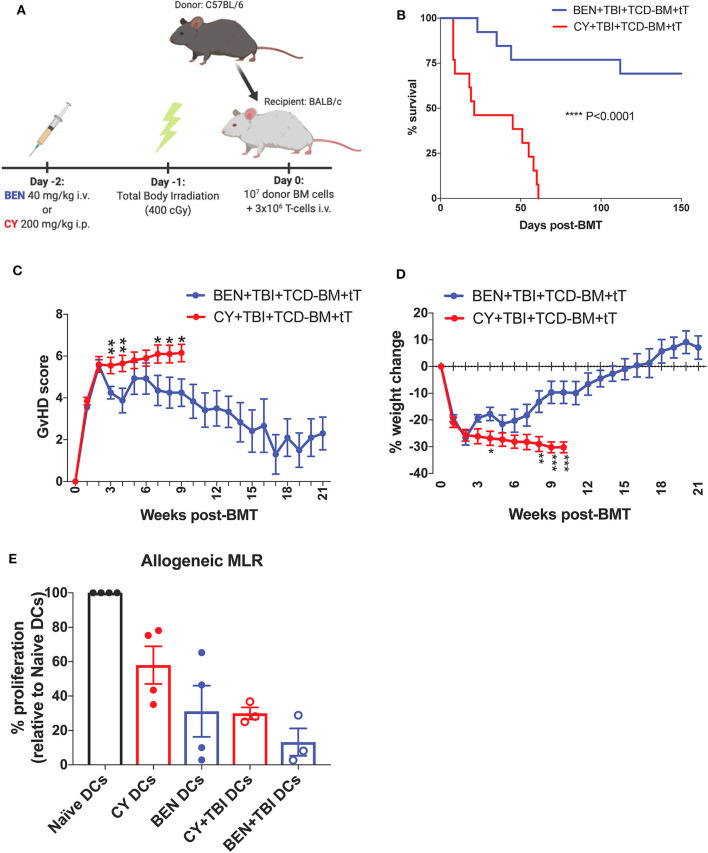
BEN+TBI compared to CY+TBI conditioning results in host DCs less stimulatory of alloreactive T-cells and improves GvHD. (A) BALB/c recipient mice received 40 mg/kg BEN i.v. or 200 mg/kg CY i.p. on day −2, 400 cGy TBI on day −1 and 107 T-cell depleted bone marrow (TCD-BM) with 3 × 106 purified T-cells (tT) on day 0. Created with Biorender.com. (B) Pooled survival data from 3 experiments are shown, n = 15 mice/group. A log-rank Mantel-Cox test was used to determine significance. ****P < 0.0001. (C) The weekly average of the mean clinical GvHD score per group is shown with SEM. (D) The weekly mean percent weight change from the starting weight with SEM is shown. Pooled data from 3 experiments are shown, n = 15 mice/group. Multiple t-tests were used to determine significance. *P < 0.05, **P < 0.01, ***P < 0.001. (E) BALB/c recipient mice received 40 mg/kg BEN i.v. or 200 mg/kg CY i.p. on day −2 and 400 cGy TBI on day −1. Splenic DCs from naïve or BEN or CY treated mice with or without TBI were isolated by MACS negative selection on day 0 and used as stimulators of allogeneic T-cells. MLRs were plated at a stimulator to responder ratio of 1:10. T-cell proliferation was assessed by tritiated-thymidine uptake after 4 days of co-culture and shown as percent proliferation (relative to Naïve DCs) with SEM. Pooled data from 4 experiments are shown, n = 3–4 mice/group. Mann-Whitney unpaired t-tests were used to determine significance (BEN vs. CY P = 0.34; BEN+TBI vs. CY+TBI P = 0.40).